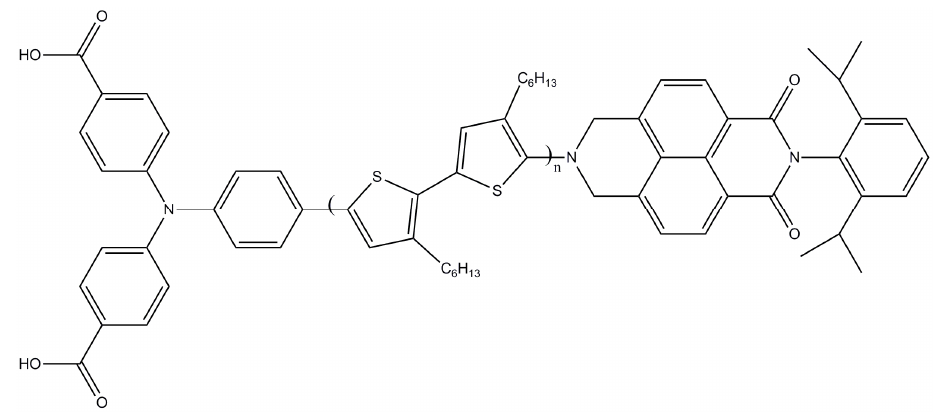
Figure 8. Structure of the molecule of PMI ‐ 6T ‐ TPA representing the best performing dye ‐ sensitizer for NiO ‐ based p ‐ DSCs [30].